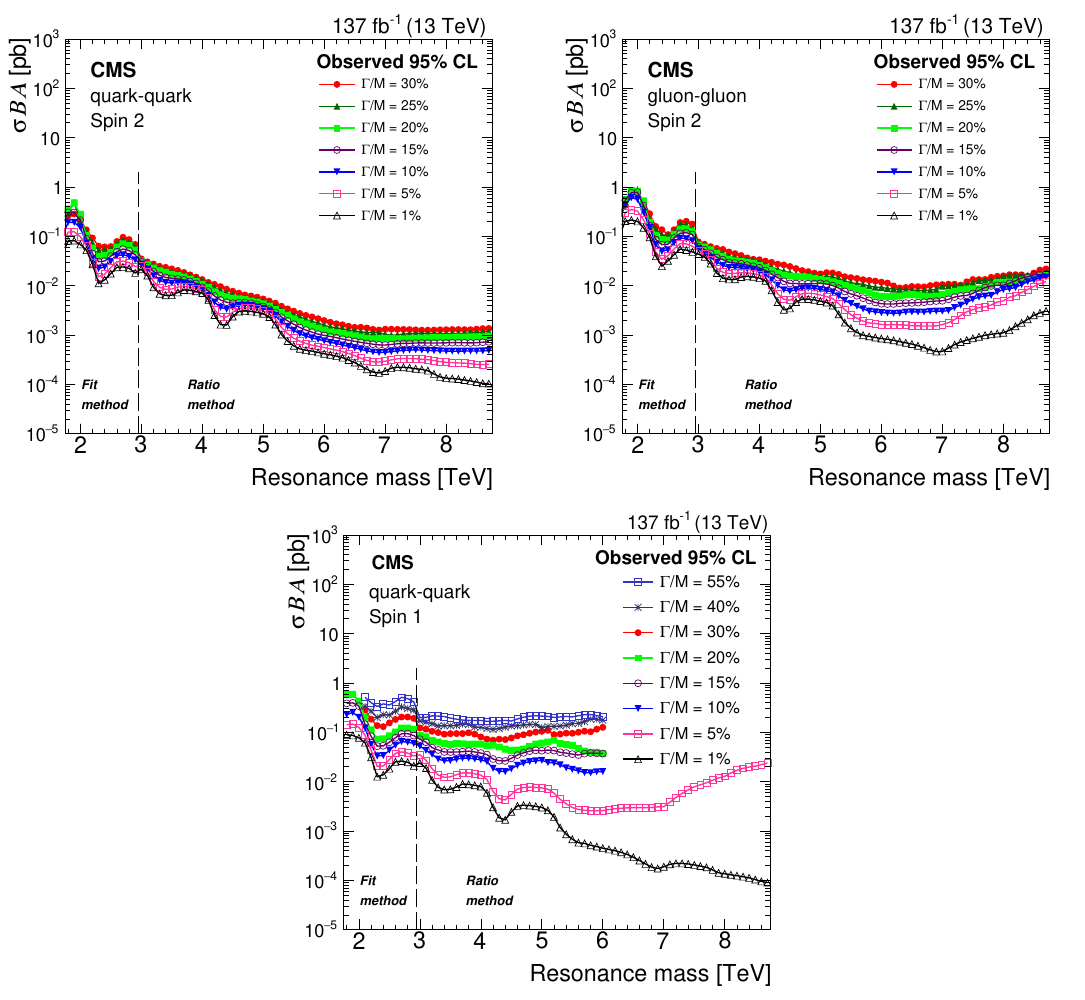
Figure 10 . The observed 95% CL upper limits on the product of the cross section, branching fraction, and acceptance for spin-2 resonances produced and decaying in the quark-quark (upper left) and gluon-gluon (upper right) channels, as well as for spin-1 resonances decaying in the quark- quark channel (lower), shown for various values of intrinsic width as a function of resonance mass. The vertical dashed line indicates the boundary between the regions where the (cid:12)t method and the ratio method are used to estimate the